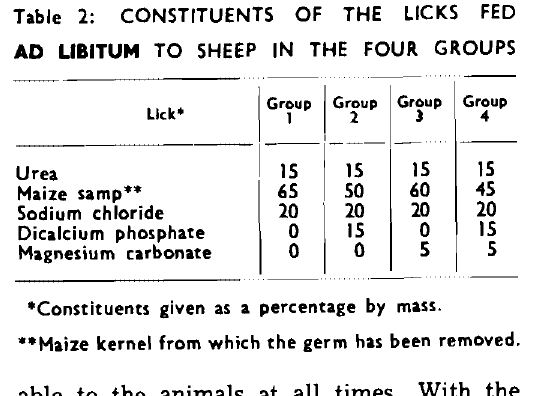
Table 2: CONSTITUENTS OF THE LICKS FED AD LIBITUM TO SHEEP IN THE FOUR GROUPS